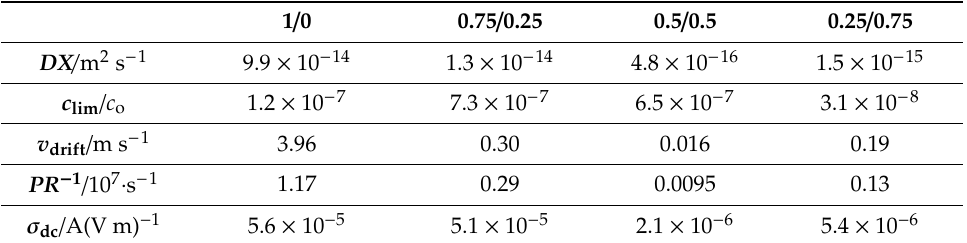
Table 1. About dynamics in PEO / PMMA blends with Y S = 0.1 Li-salt at 298 K. Generalized di ff usion coe ffi cient, limiting solubility c lim / c o , drift velocity and entropy production. 1 /